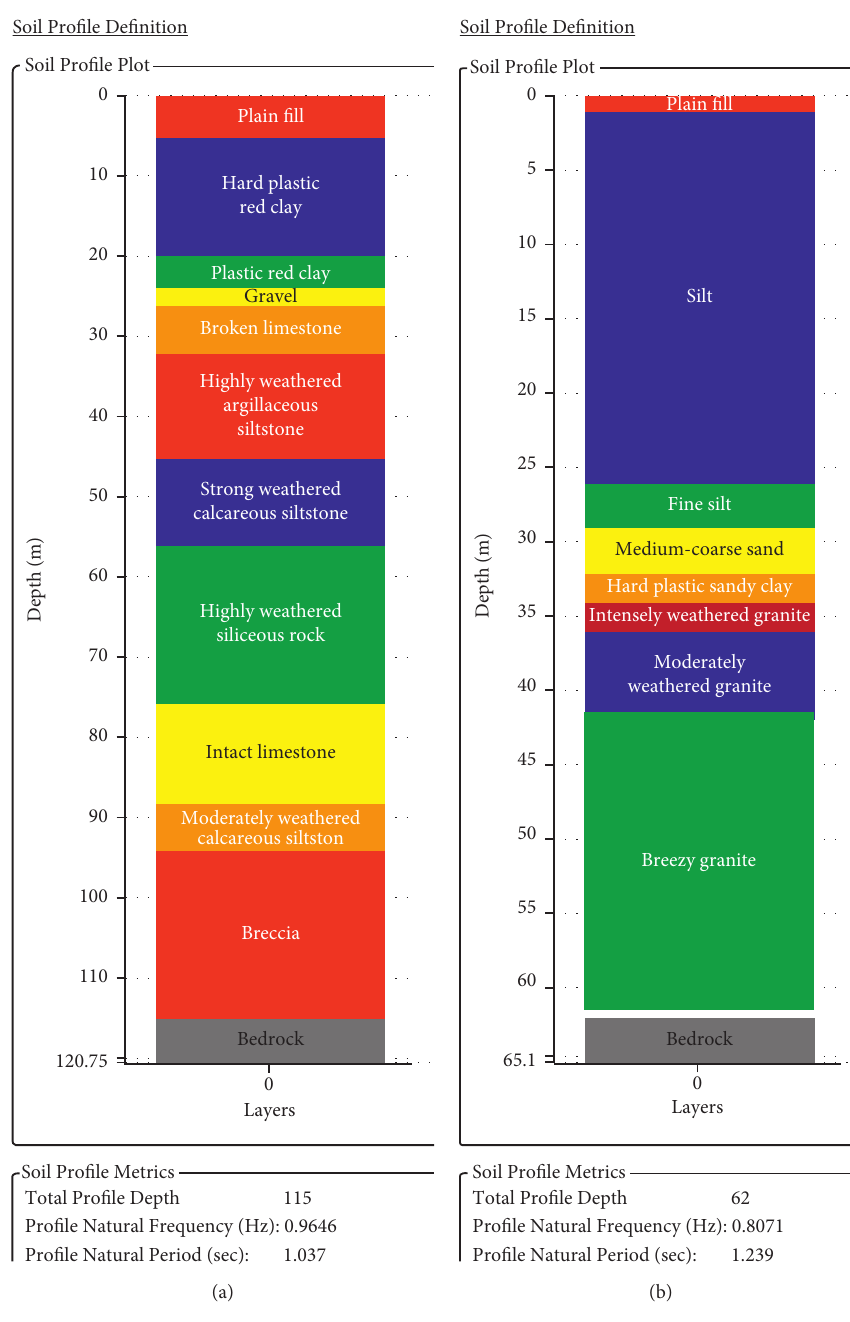
Figure 1: Establishment of the model: (a) model 1 and (b) model